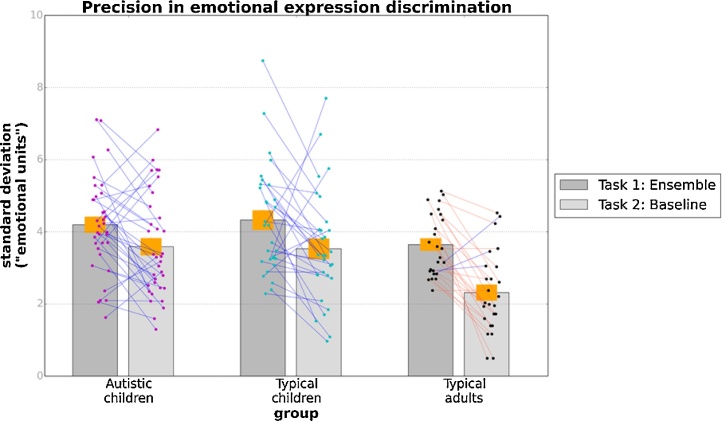
Mean precision for emotion discrimination (mean of standard deviations of the fitted psychometric curves) in the ensemble (Task 1) and individual emotion (Task 2) discrimination tasks for autistic children, typical children and typical adults. The orange bands correspond to ±1 SEM. Points superimposed on bars show individual variability, while blue lines connect data from the same participant.